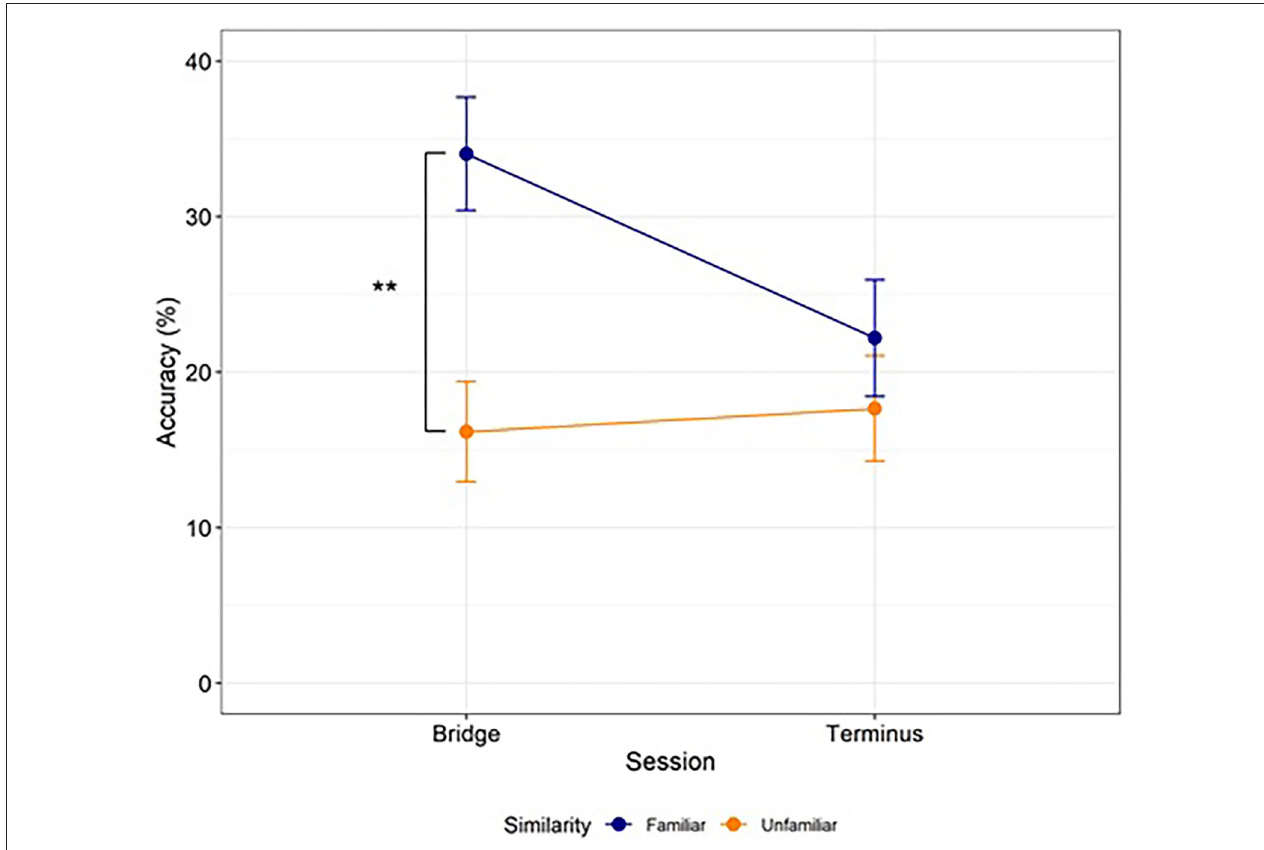
FIGURE 1 | Word learning accuracy. Learners in the Familiar condition (blue) acquired more words in the Bridge session than learners in the Unfamiliar condition (orange), providing evidence of a between-language similarity benefit. Accuracy decreased from the Bridge to the Terminus session for learners in the Familiar condition. Dots and error bars represent observed values and standard error, respectively, by participants. Lines represent the best fit linear mixed-effects regression model. ** p <